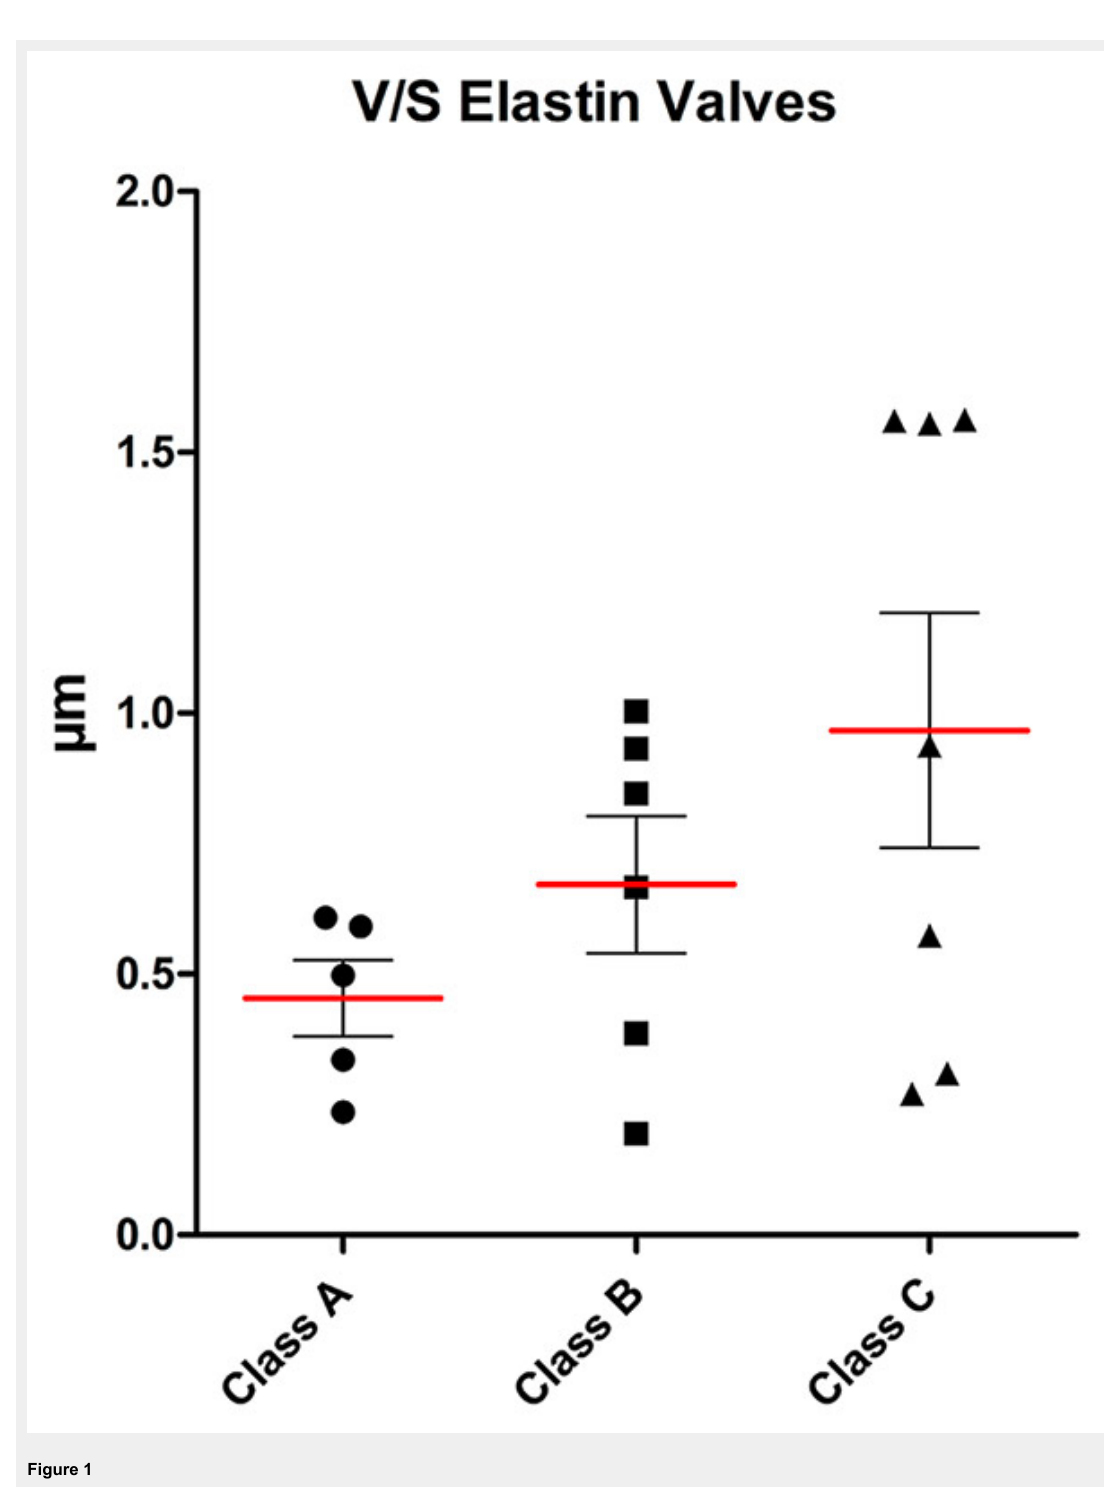
Figure 1 Volume-to-surface ratio of the elastin content of valves for the three classes ■(mean (red line), standard deviation and individual